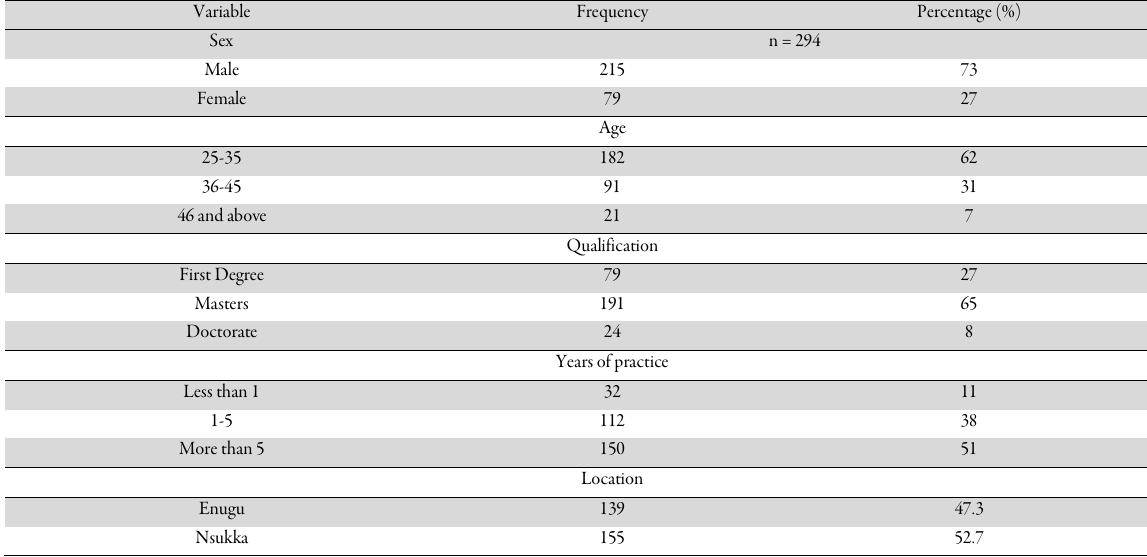
Table 1. Sociodemographic characteristics of the respondents